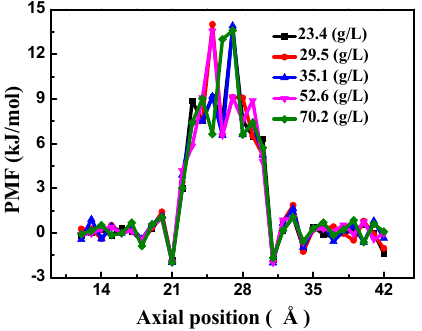
Figure 3. The potential of mean force (PMF) of the bilayer porous graphene membrane as a function of the salt concentration.